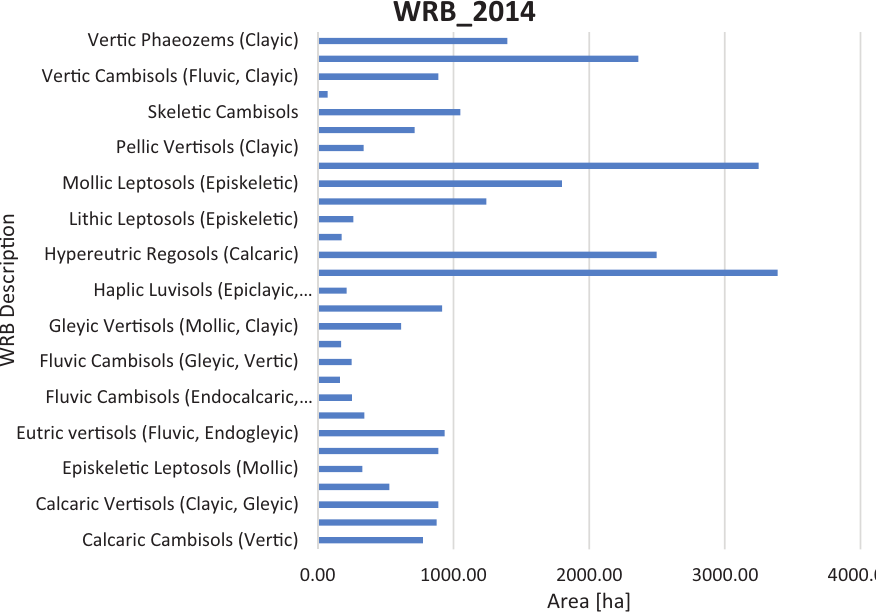
Figure 9. The areas of soil